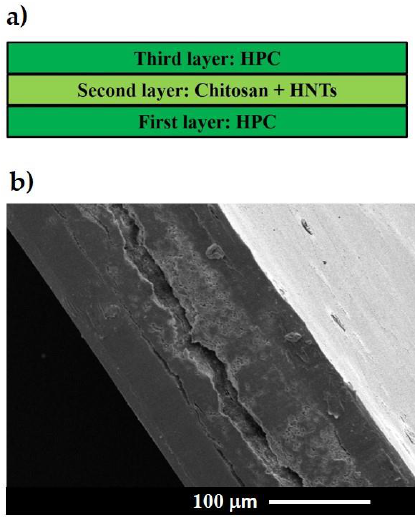
Figure 1. The sketch of the multilayer structure of the nanocomposites ( a ) and the scanning electron microscope (SEM) image for the composite materials with R (C+H)/HPC = 2.81 ( b ).